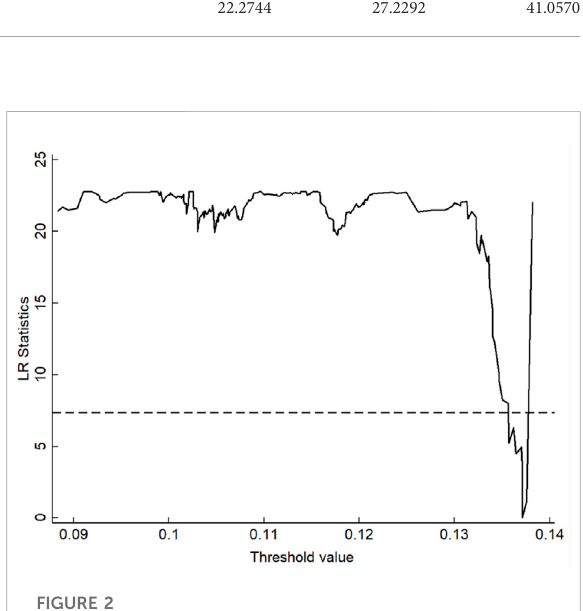
FIGURE 2 Con fi dence intervals for the single-threshold